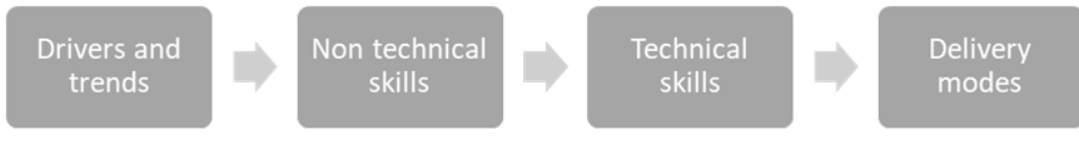
Figure 1. Research workflow.